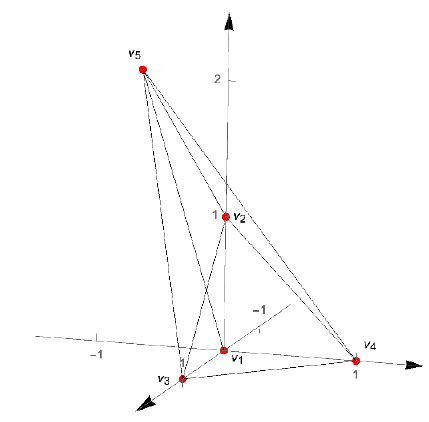
Figure 1 . Toric diagram of Y p;k ( C P 2 ) with p = 1, k = 2, obtained by projecting on R 3 the vertices in